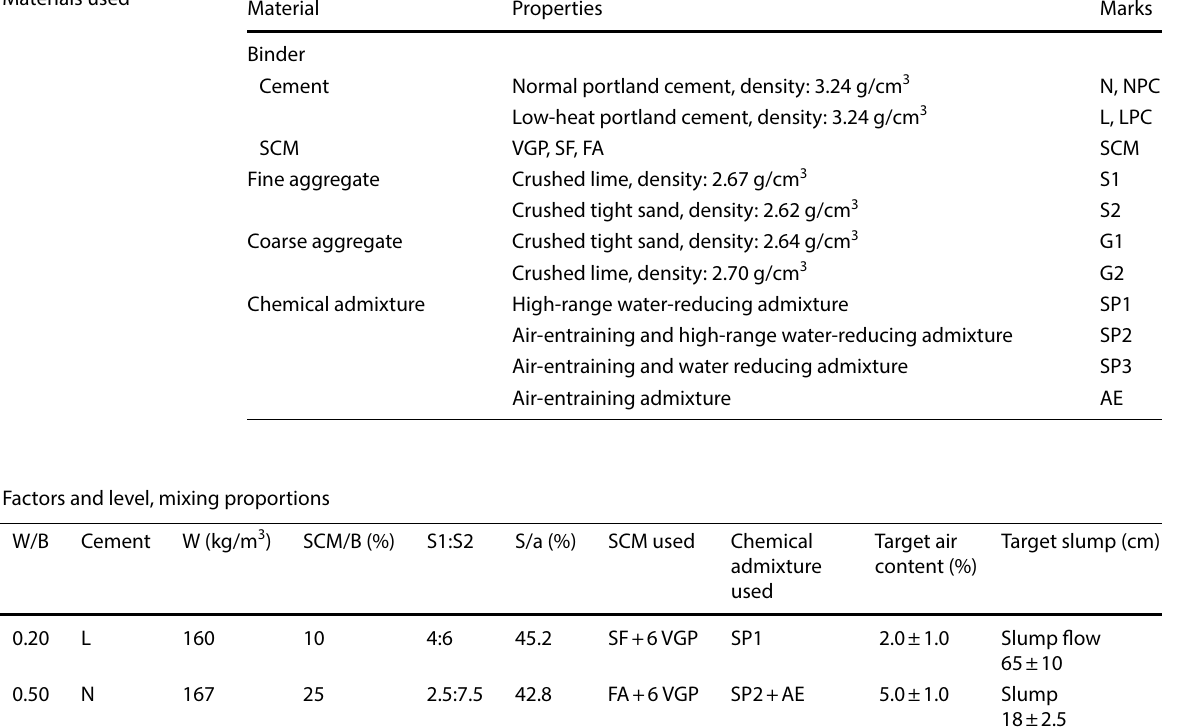
Table 2 Materials used Material Properties